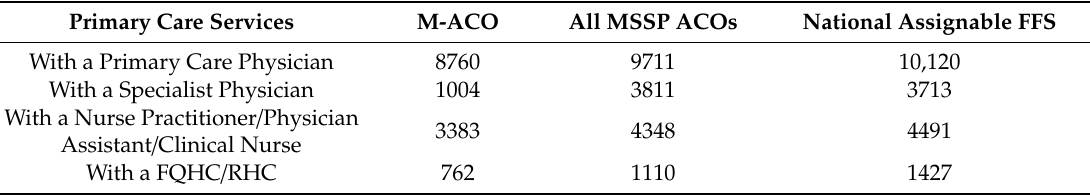
Table 5. Primary Care Services as publicly reported by CMS. FQHC / RHC = Federally Qualified / Rural Health Clinic; FFS = Fee for